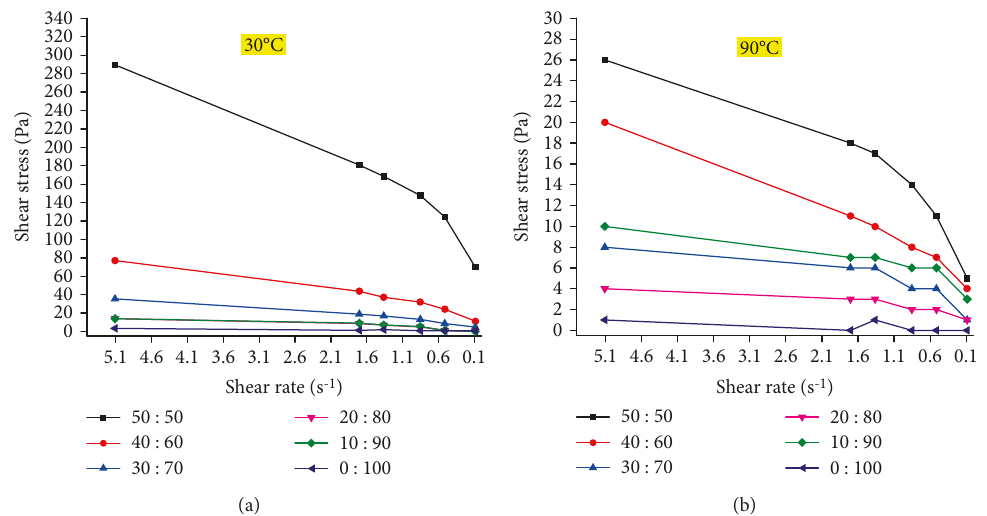
Figure 9: The relationship between shear rate and shear stress at di ff erent